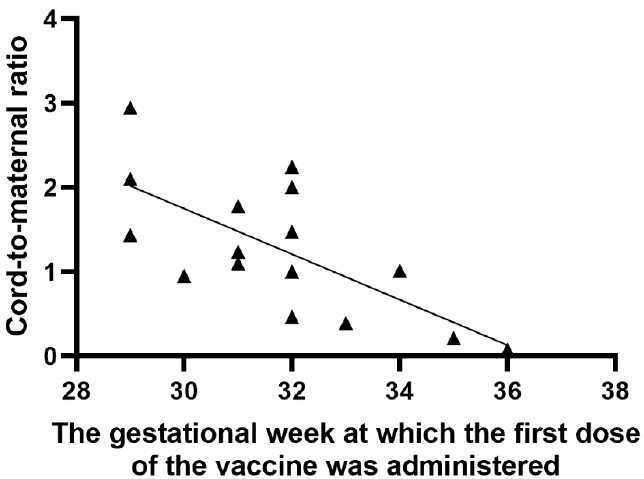
Figure 5. Correlation between the period (weeks) from the second vaccine dose to delivery and cord-to-maternal anti-S titer ratio.